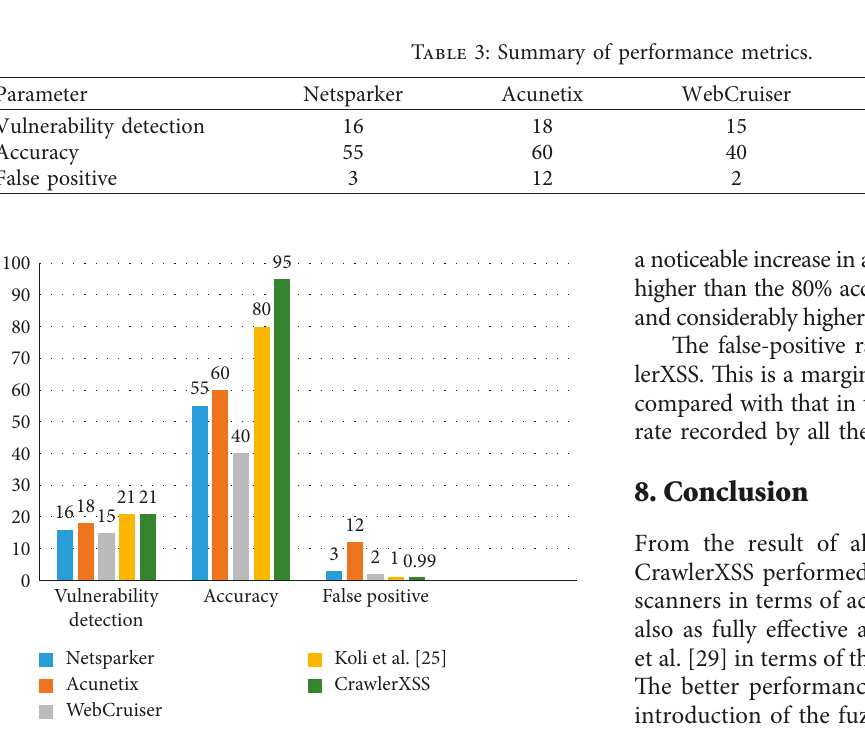
Figure 6: Graphical summary of performance metrics.